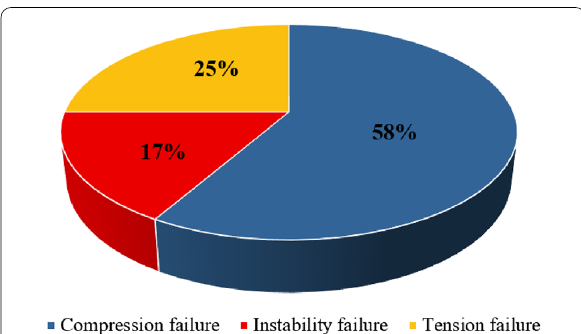
Fig. 9 Distribution of failure modes